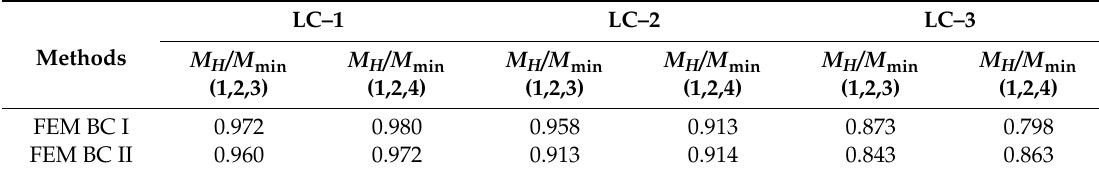
Table 14. Maximum bending moments corresponding to the destruction of the composite layer for the FRP beam.